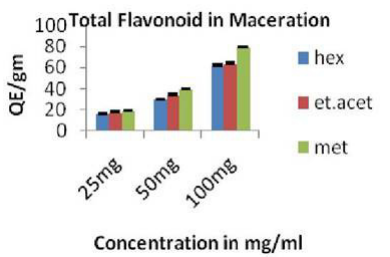
Fig. 4. Total flavonoid content in